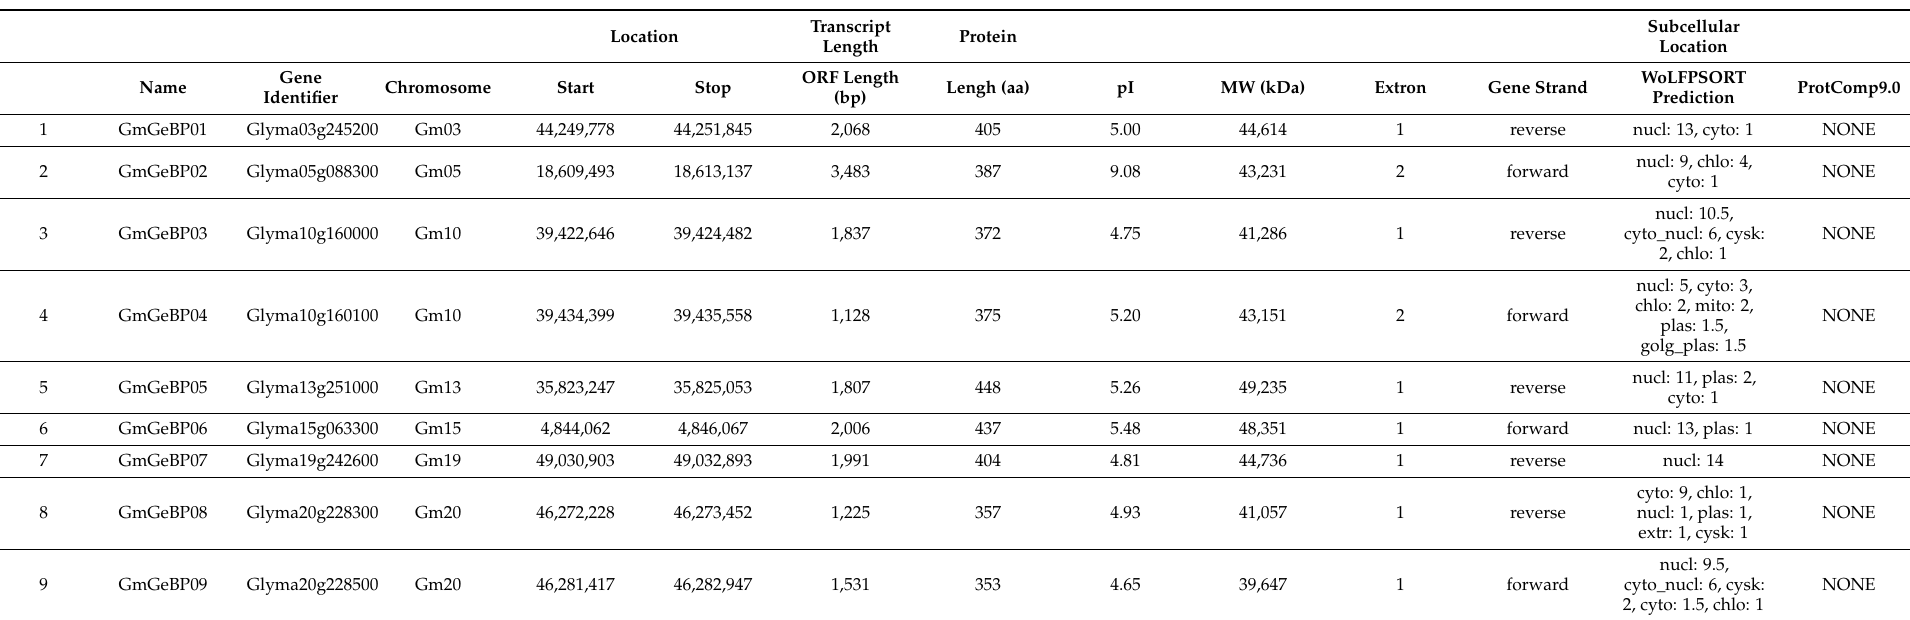
Table 1. The information on the GeBP gene family in soybean. Location Transcript Length Protein Subcellular